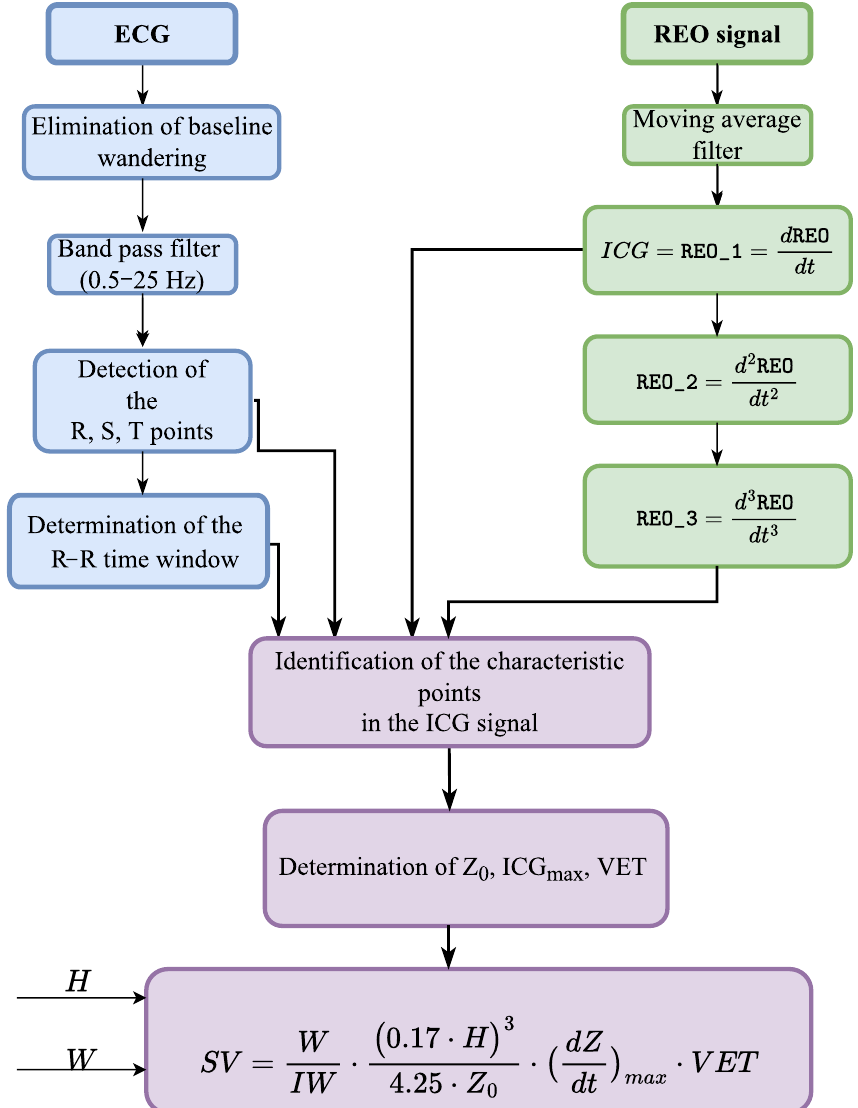
Figure 3. Sketch of an algorithm detecting fiducial points B, C, and X in the ICG signal within one cardiac